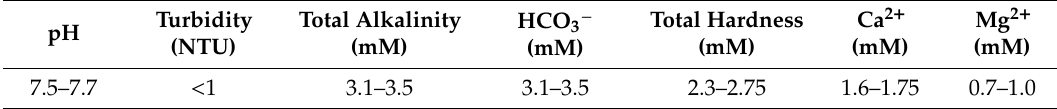
Table 1. Summary of the water quality parameters of the circulating water.